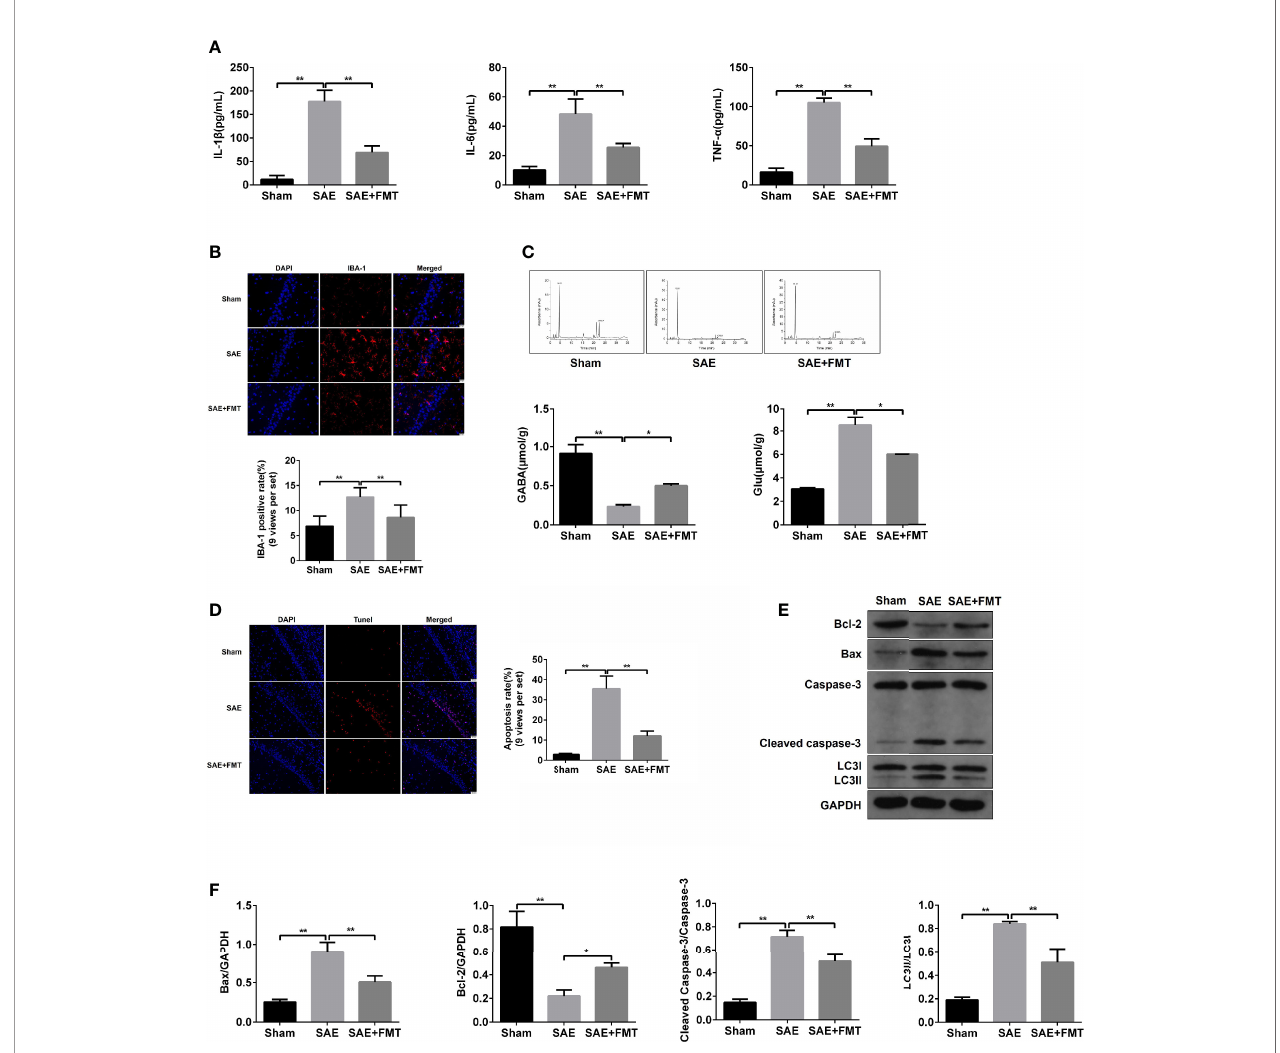
FIGURE 2 | Effects of FMT on hippocampus impairment in SAE rats. (A) In hippocampus tissues of Sham-operated, SAE, and FMT-challenged SAE rats, the expression of in fl ammation cytokines interleukin (IL)-1 b , IL-6, and TNF- a as determined by ELISA. (B) The expression of ionized calcium binding adaptor molecule (IBA) in paraf fi n-embedded hippocampus tissues as measured using IF staining. Red: IBA-1-positive signals; blue: DAPI. Relative quantitation of IBA-1-positive cells as shown below (nine views per set). (C) Based on the HPLC, the concentrations of glutamic acid (Glu) and gamma-aminobutyric acid (GABA) were detected in the hippocampus tissues of the three groups (Sham-operated, SAE, and FMT-challenged SAE rats). (D) TUNEL assay was used to determine the number of apoptotic cells in the hippocampus tissues obtained from Sham-operated, SAE, and FMT-challenged SAE rats. Relative quantitation of TUNEL-positive cells as shown in the right (nine views per set). (E) The protein levels of B-cell lymphoma (Bcl)-2, BCL2 associated X (BAX), cleaved caspase 3, and LC3II/I were detected by Western blotting assay in the hippocampus tissues of Sham, SAE, and FMT-exposed SAE rats. (F) Protein quantitative analysis of Bcl-1, BAX, cleaved caspase 3, and LC3II/I in panel (E) of this fi gure. *P < 0.05. **P <